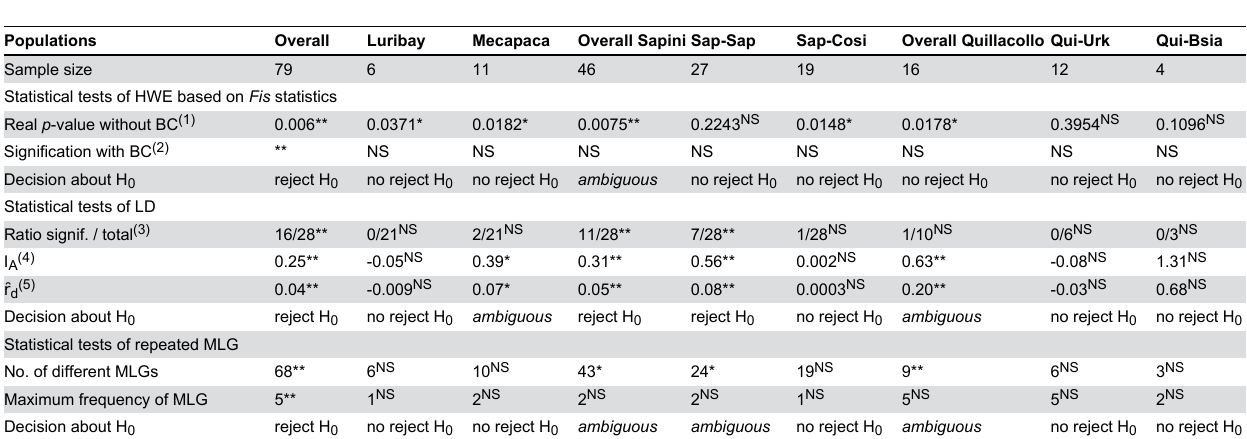
Table 3. Analysis of F , disequilibrium linkage (LD) and repeated multilocus genotypes (MLGs) of the 79 Trypanosoma cruzi is strains isolated from six potentially panmictic